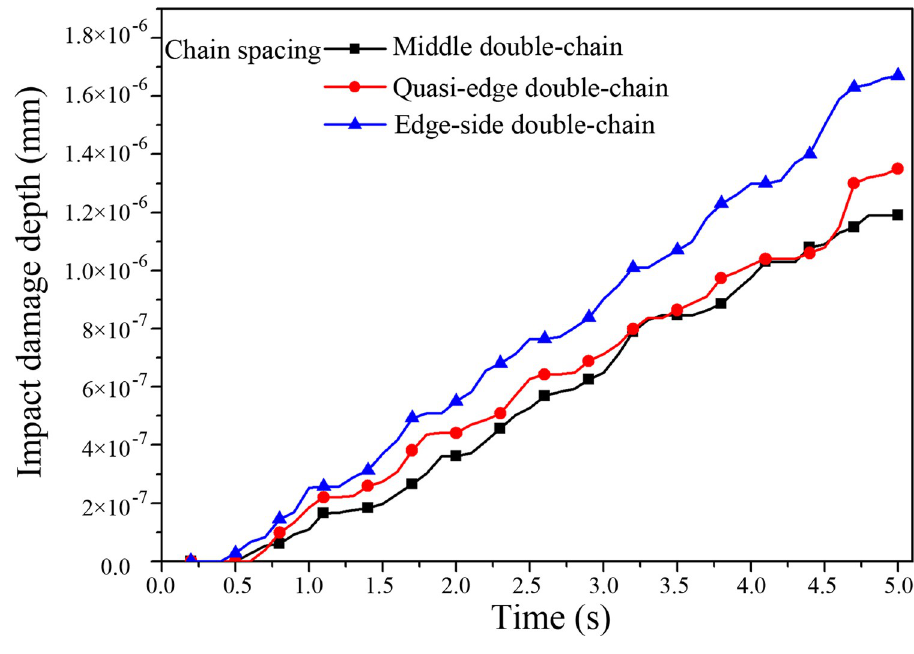
Fig 10. Impact damage depth curve of the middle trough under the different chain spacings.